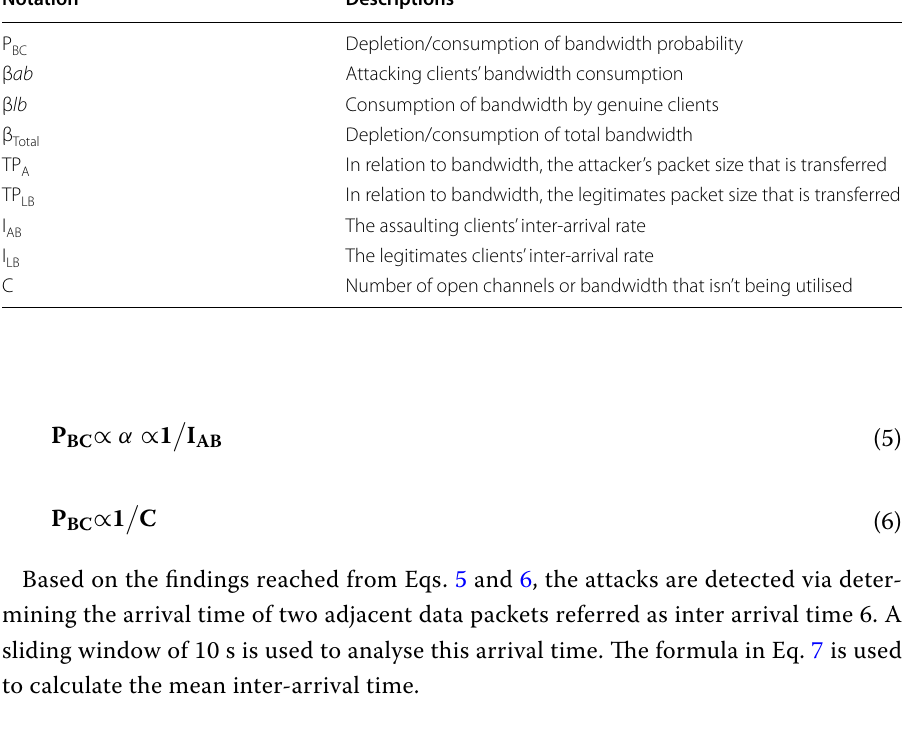
Table 4 The notations used in mathematical models